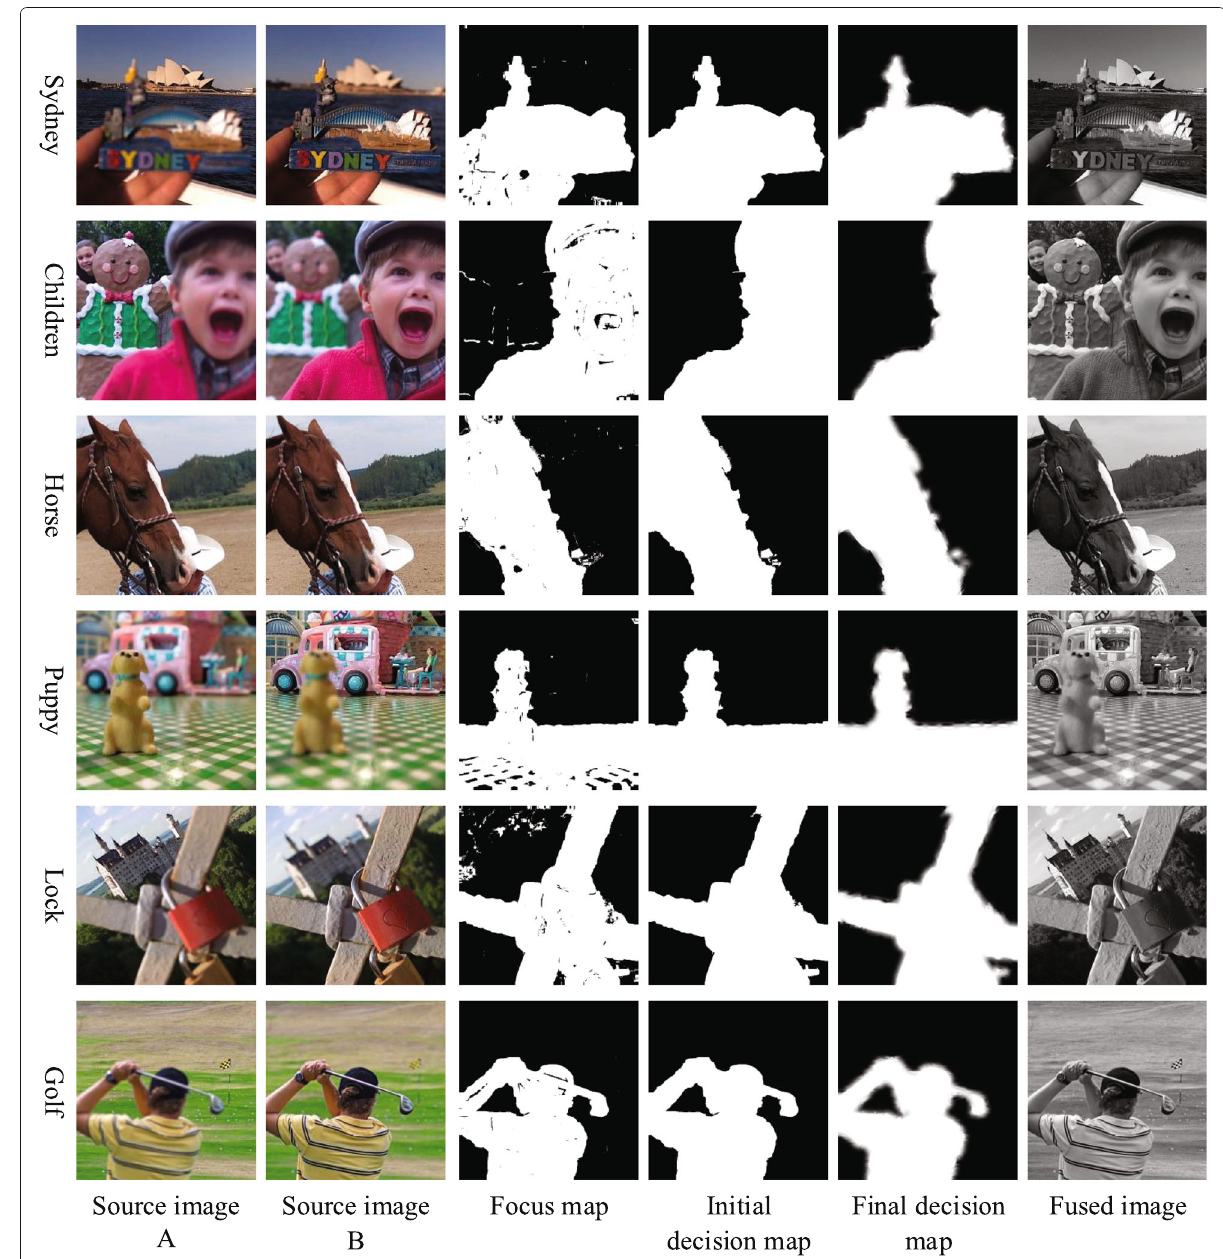
Fig. 6 Intermediate fusion results of portion test images in our method. For each test image, we convert it into gray-scale space. Then, intermediate results of image fusion process are present. The effect of focus map and decision map are significant